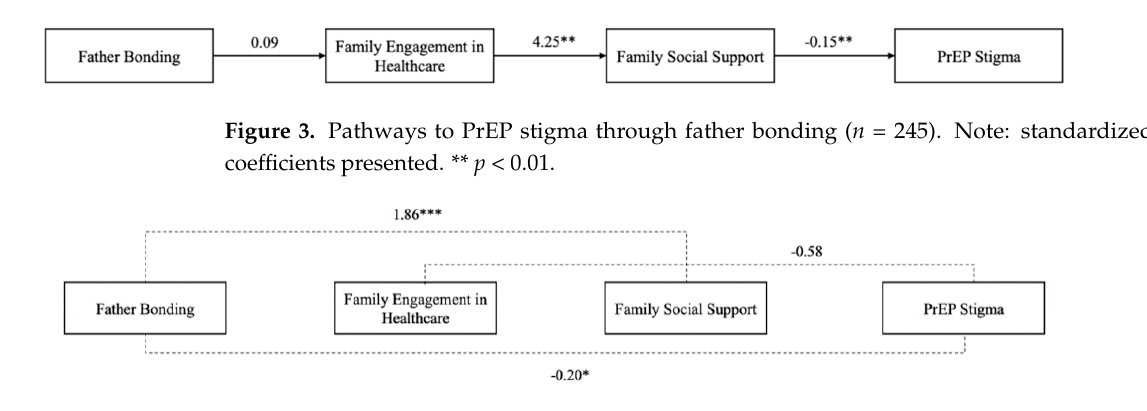
Figure 4. Indirect pathways to reduction in PrEP stigma ( n = 399) through father bonding. Note: standardized path coefficients presented. * p < 0.05; *** p < 0.001.